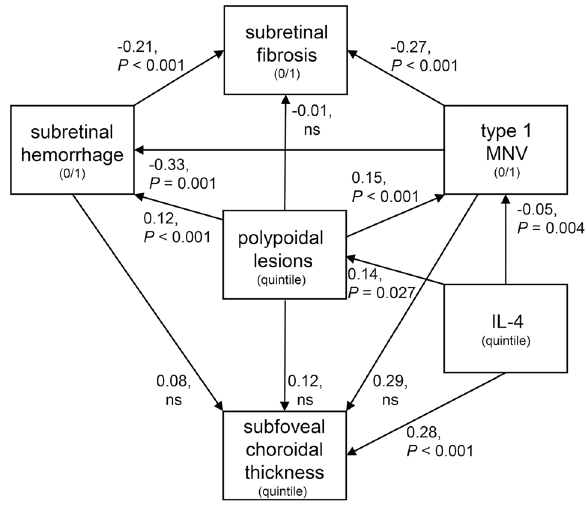
Figure 2. Structural equation modeling path diagrams for associations among IL-4 level and disease characteristics. Associated cytokines and pathological choroidal features associated with pachychoroid neovasculopathy and neovascular age-related macular degeneration are shown in the path diagram using structural equation modeling. Subretinal hemorrhage, subretinal fibrosis, and type 1 MNV were coded as 0/1. IL-4, subfoveal thickness, and polypoidal lesions were coded as 0/1/2/3 based on quintile. Structural equation modeling construction with the inclusion of clinical characteristics was conducted by assessment using fitting indices, Akaike information criteria (AIC), and Bayesian information criteria (BIC). Arrows are shown with coefficients of association and P -values in the path diagram. Comparative fit index: 1.000, root mean square error of approximation: < 0.001, MNV: macular neovascularization, polypoidal lesions: numbers of polypoidal lesions at the macular lesion. ns, not significant, n =